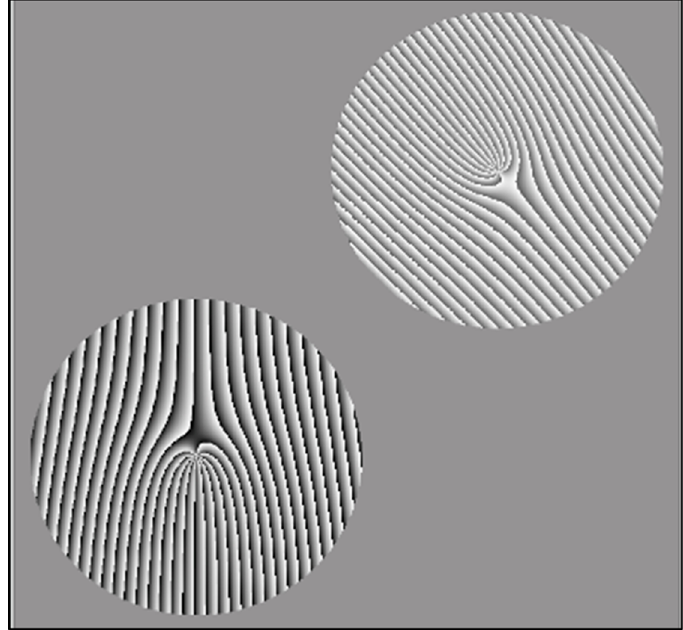
Figure 7. LabView VI for vortex manipulation. Patterns are displayed on separate sections of the SLM, and each pattern is calibrated for a particular wavelength, with different grayscale.